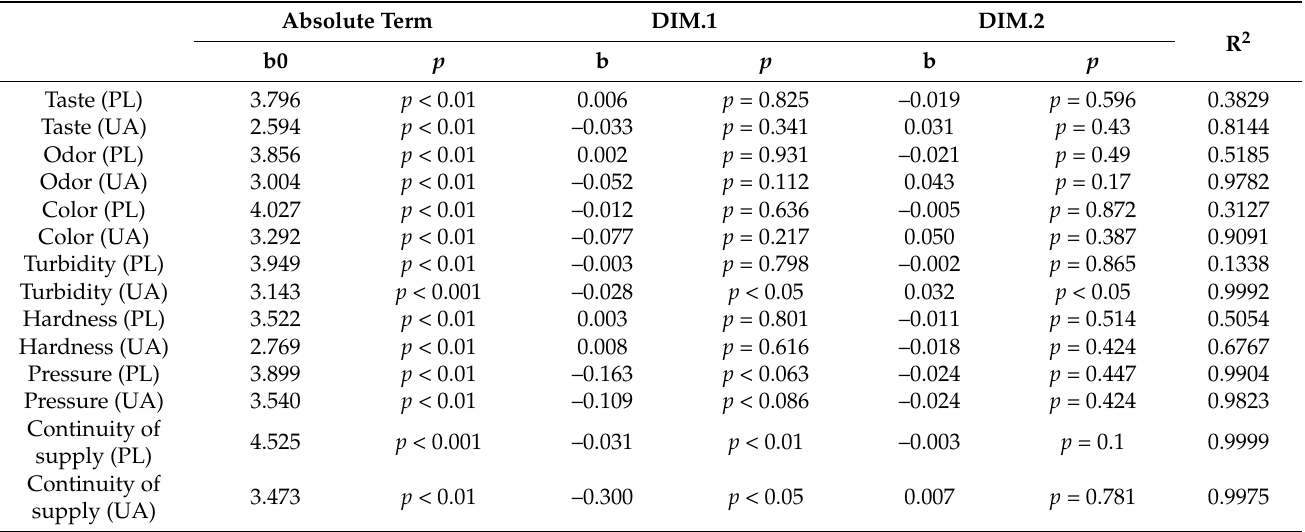
Table 17. Results of regression analysis between parameters of tap water supplied in Poland and Ukraine and dimensions of the studied